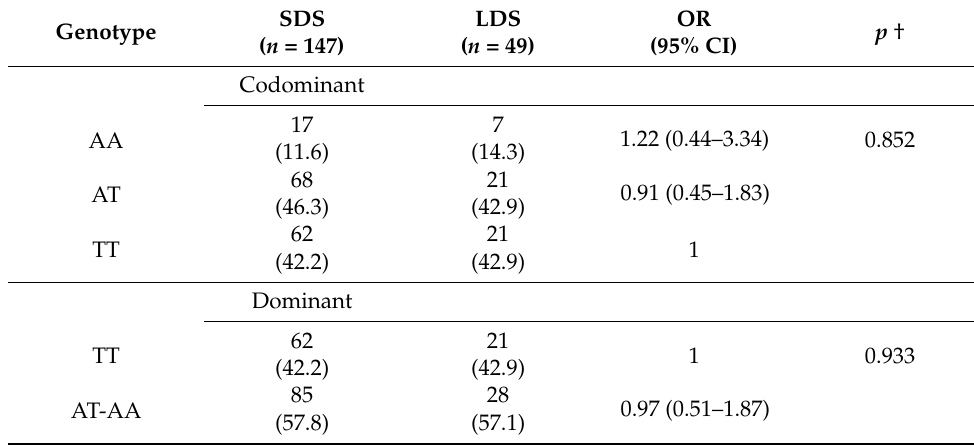
Table 2. Comparison of SDS against LDS (genotypes and